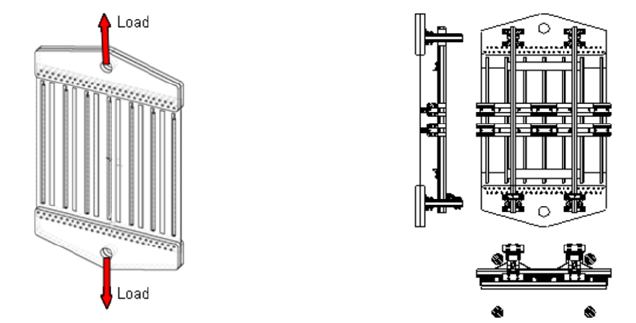
Figure 5: Representation of the clamping system (on the left) and of the anti-bending device (on the right). The observed crack lengths within the two bays were practically symmetrical: this has permitted to draw the crack propagation curves [ a = f(N) ] considering the average crack length between the left and right crack tip displacement (see